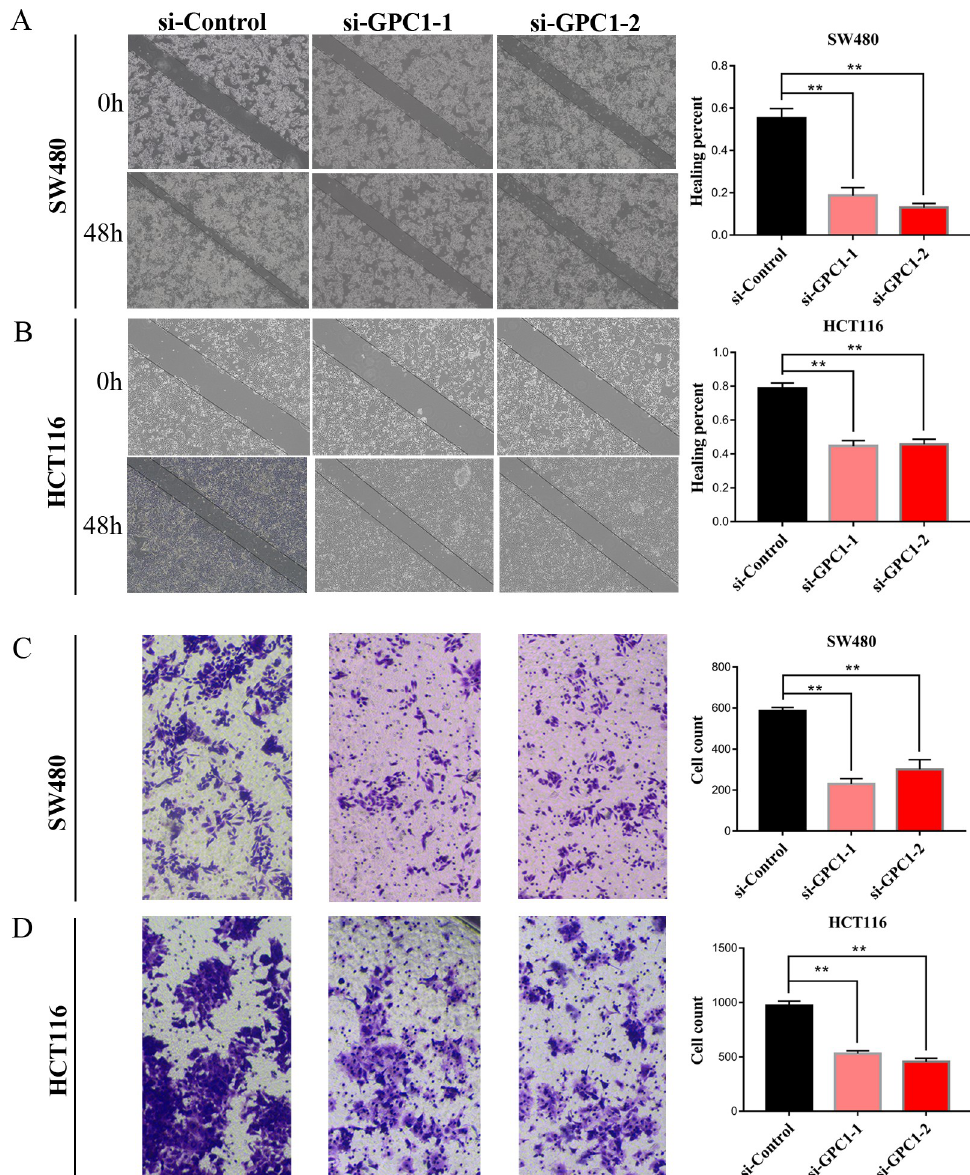
Fig 5. Silencing GPC1 significantly reduces cell migration ability in CRC cells. (A, B). Knockdown of GPC1 significantly inhibited wound healing in SW480 and HCT116 cell lines. (C, D). Silencing GPC1 significantly impaired the cell migration in SW480 and HCT116 cell lines. �� p <